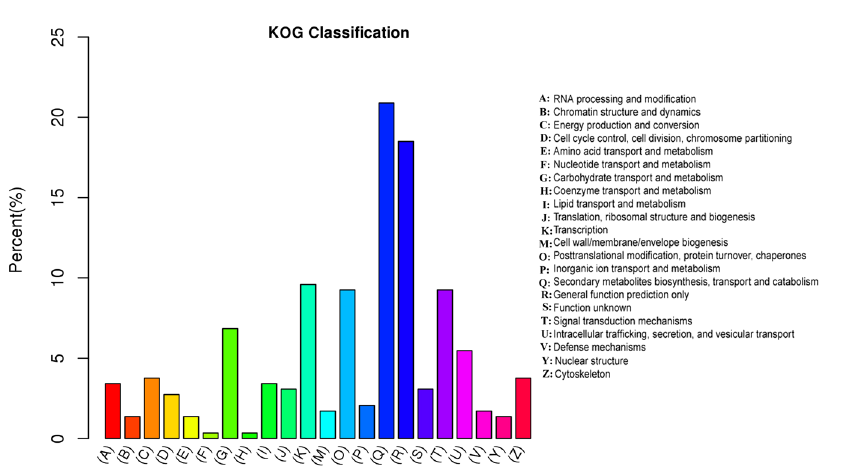
Figure 5. The GO classification of miRNA targets. These miRNA targets are predicted by computational program described in the method section. The majority of miRNA targets have been confirmed experimentally in previous reports.